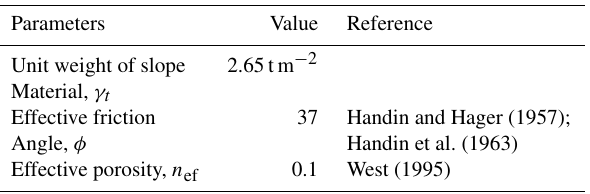
Table 1. Parameters for calculating critical height of water Q C